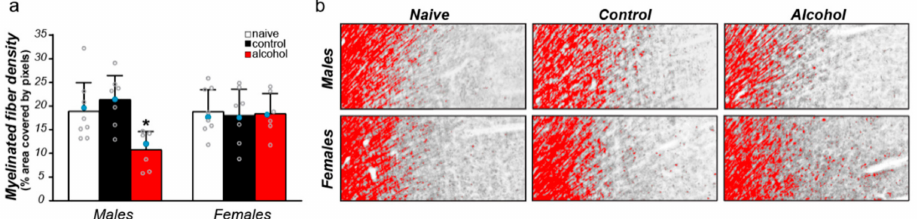
Figure 2. Adolescent alcohol drinking decreases myelinated fiber density in male, but not female, rats. ( a ) Adolescent alcohol drinking decreases myelinated fiber density in the Cg1 of males (* p = 0.01), with no measurable changes detected in females. Blue circular markers indicate the individuals used for representative images in panel b. Note: the fiber density means ± SEM were previously published for males [18]. ( b ) Representative microscopic images from each treatment group, with fibers displayed in red to show density threshold measurements. These representative images were taken with a 5 × objective on a light microscope and processed in Image J (open source from https: // imagej.net / ImageJ) for enhanced visualization for this figure. Myelin density data were analyzed on scanned images using Aperio ImageScope software (Leica Biosystems Imaging Inc., Vista, CA, USA), as described in the